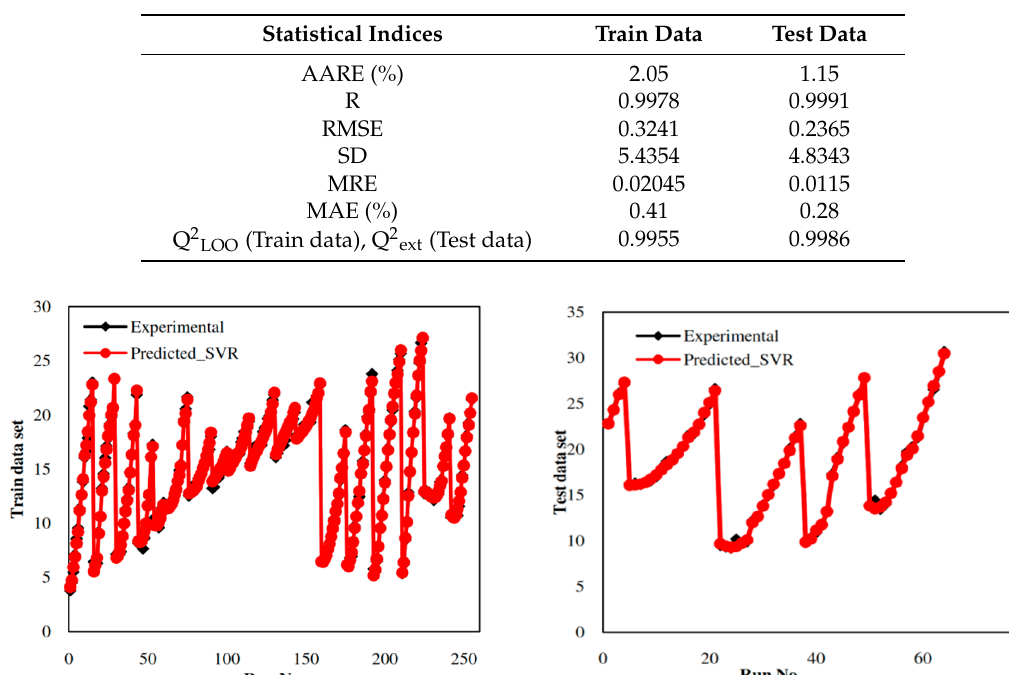
Table 3. Optimal parameters of the SVR model for the prediction of heat transfer coefficient of R600a.